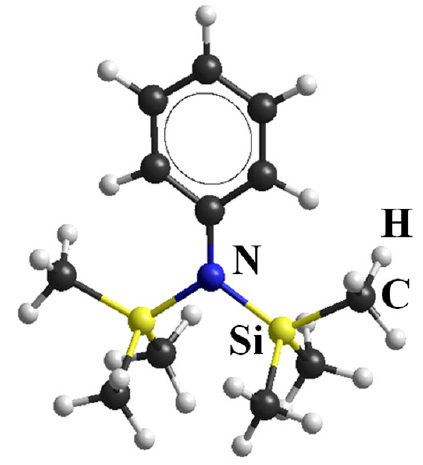
Figure 1. Bis(trimethylsilyl)phenylamine (BTMSPA).